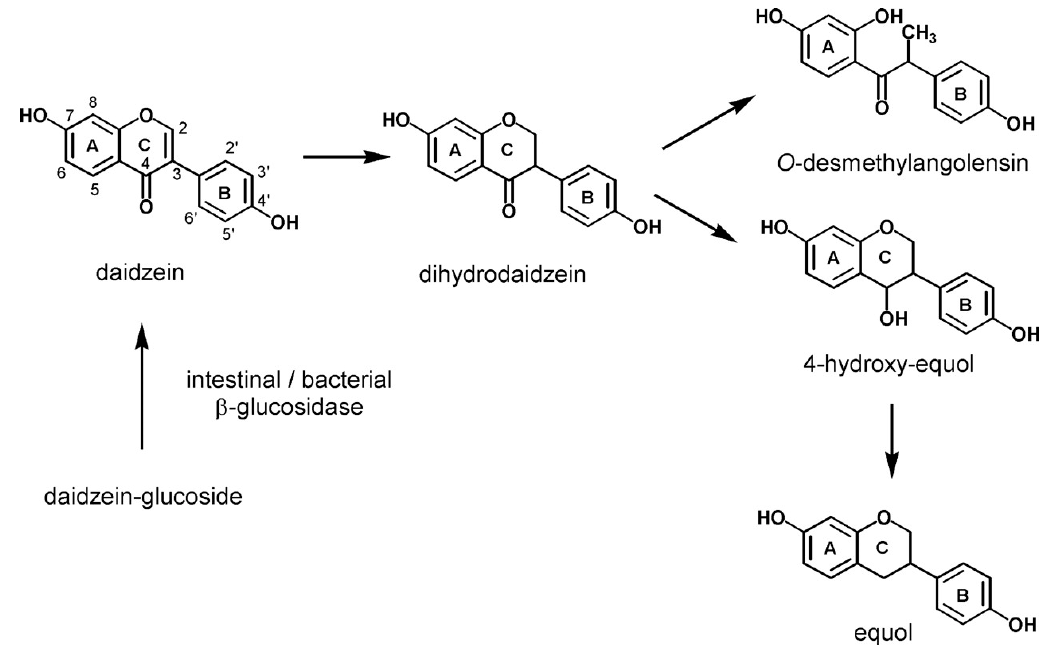
Figure 1. Formation and metabolism of daidzein [15].